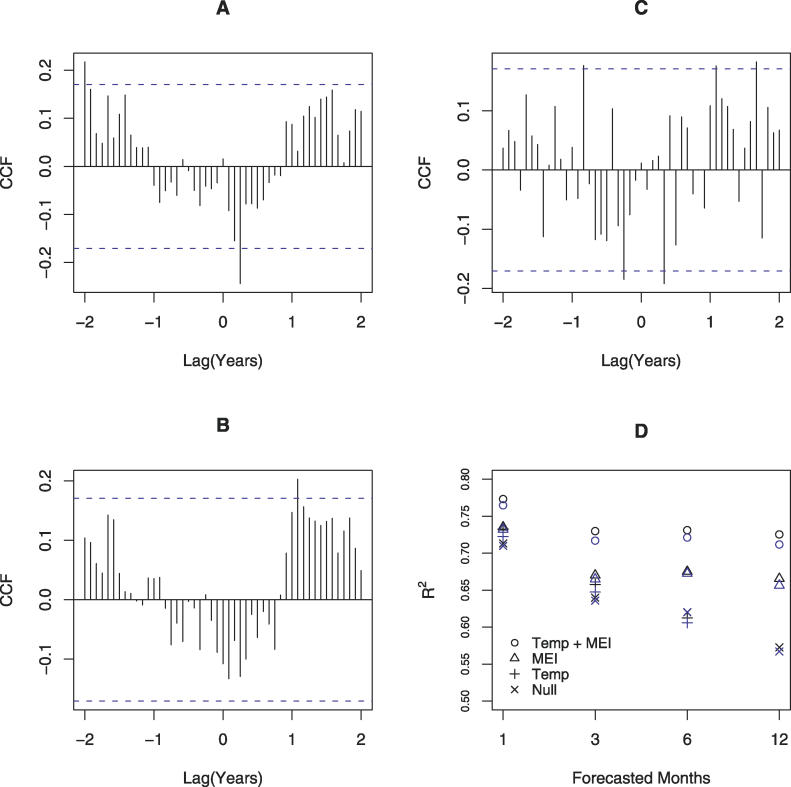
Cross-Correlation Functions of Square-Root-Transformed Cases with SST 4, Temperature, and MEI(A–C) Cross-correlation functions (CCF) with (A) SST 4, (B) MEI, (C) Temperature. The blue dashed lines are the 95% point confidence intervals for the cross-correlation between two series that are white noise [23].(D) Predictive R
2 measuring the accuracy of the predictions. Blue is for predictions with only 9 y of training data (used to fit the model) and black for predictions generated with all months preceding the prediction. (The value for 12-mo predictions with temperature is not shown, because it was negative.)